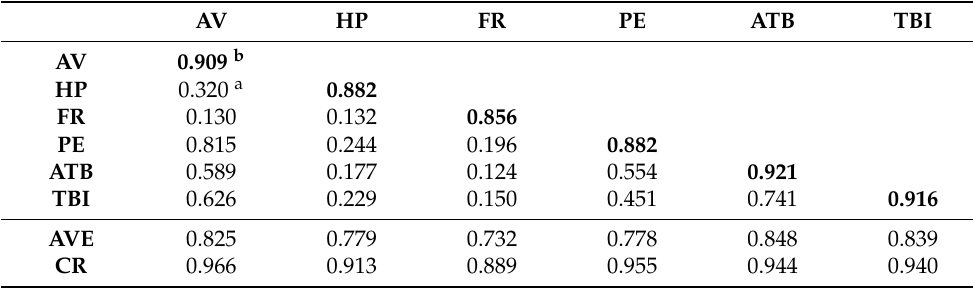
Table 2. Summary of the confirmatory factor analysis results. AV HP